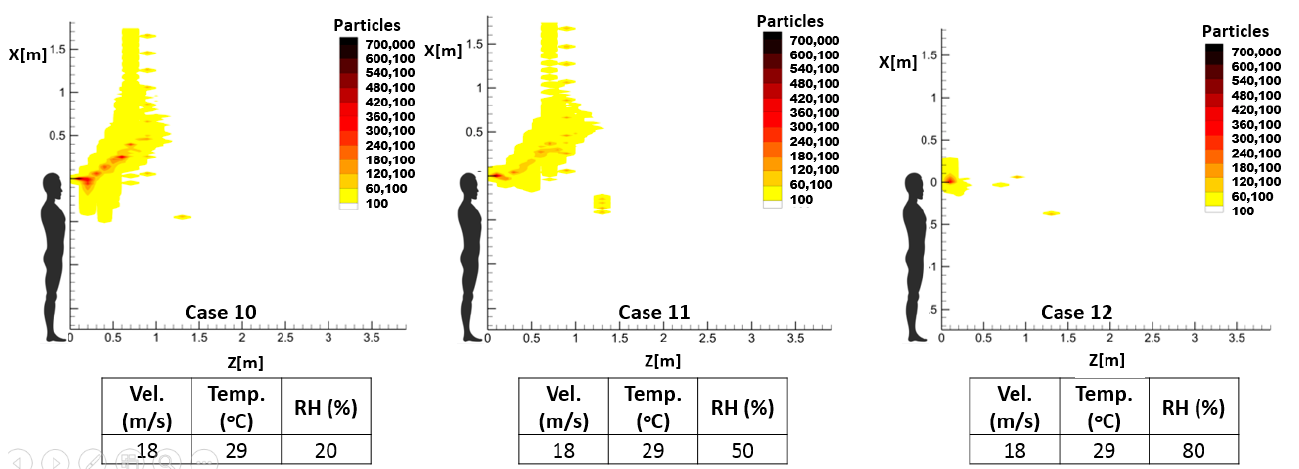
Figure 14. Risky regions with more than 100 accumulated droplets of sneeze cases 10 to 12 after 60 s.